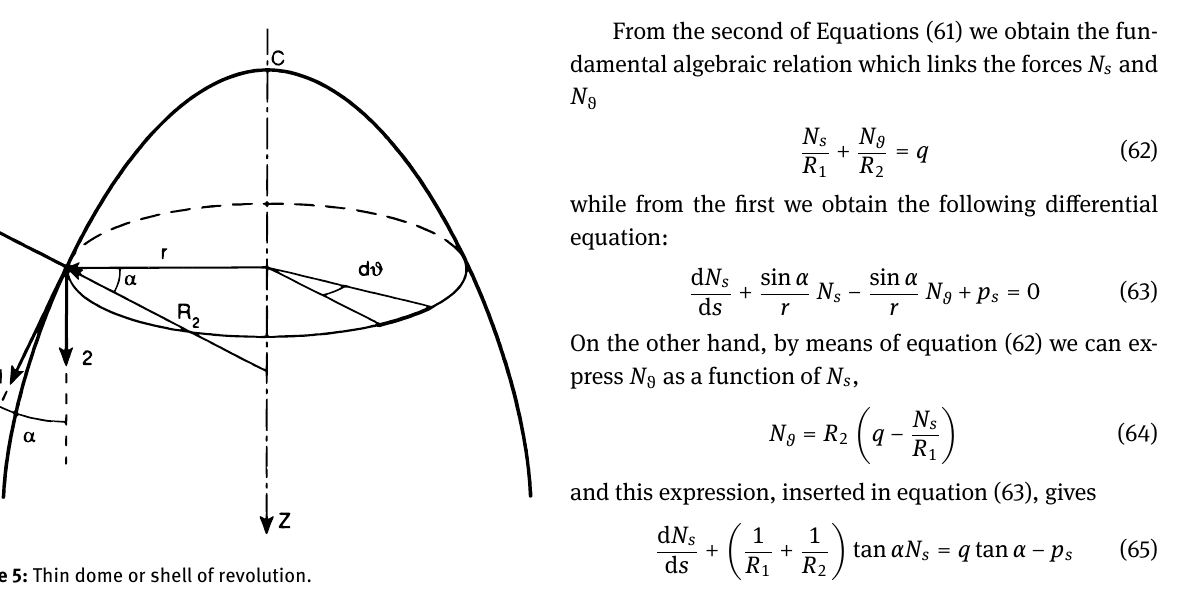
Figure 5: Thin dome or shell of revolution.